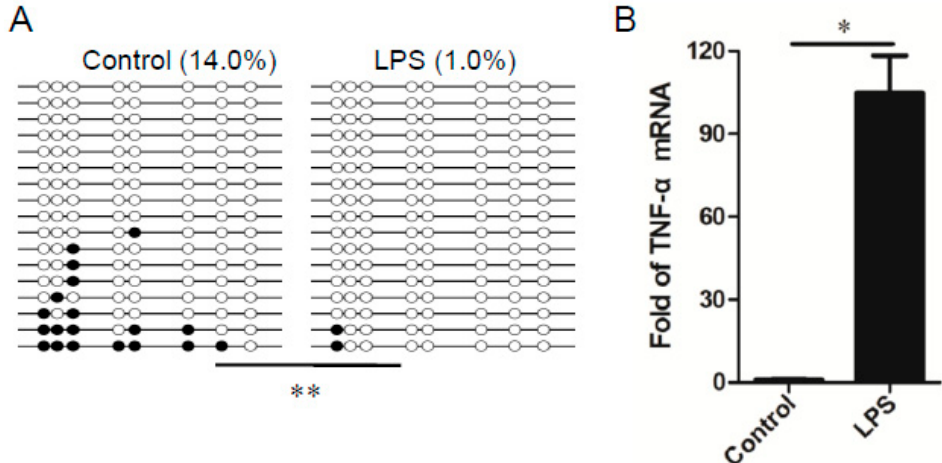
Figure 5. ( A ) The DNA methylation level of TNF- α promoter region was analyzed by Bisulfite sequencing PCR (BSP). Each line represents one individual sequenced clone. One circle represents one CpG site: the open circle shows unmethylated CpG; the black circle shows methylated CpG. Note that LPS stimulation significantly reduced the DNA methylation level of TNF- α promoter region in comparison to control groups. The difference between LPS group ( n = 3) and control group ( n = 3) was calculated by Fisher’s exact test, **, p < 0.01. ( B ) The relative expression of TNF- α in PAM with or without LPS treatment was analyzed by qRT-PCR. Note that LPS stimulation promoted TNF- α expression in comparison to control group. n = 3, the data shown are mean (SD), *, p < 0.05.